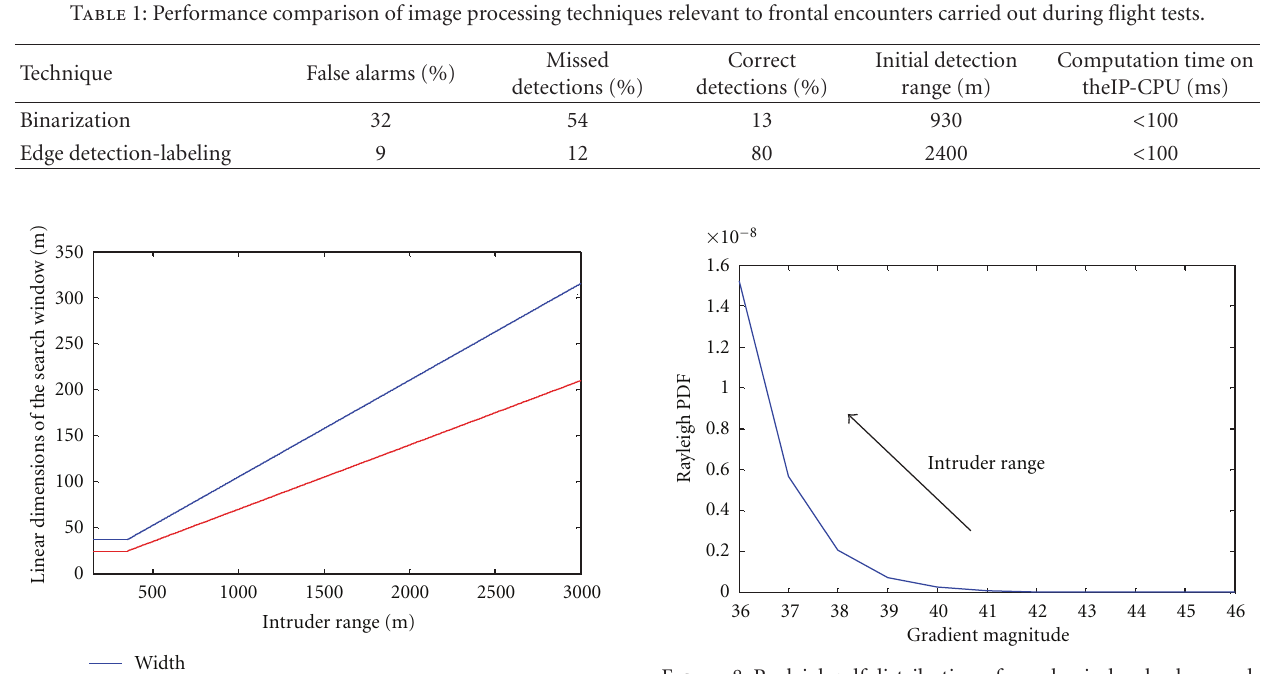
Figure 8: Rayleigh pdf distribution of search window